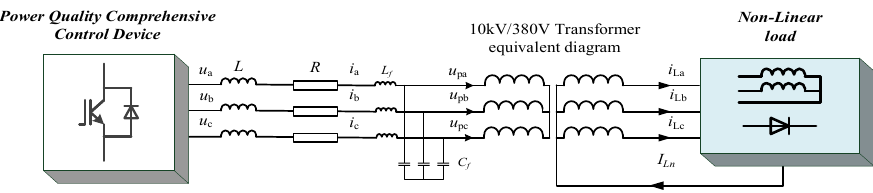
Figure 3. Equivalent model of circuit on the output side of the device.